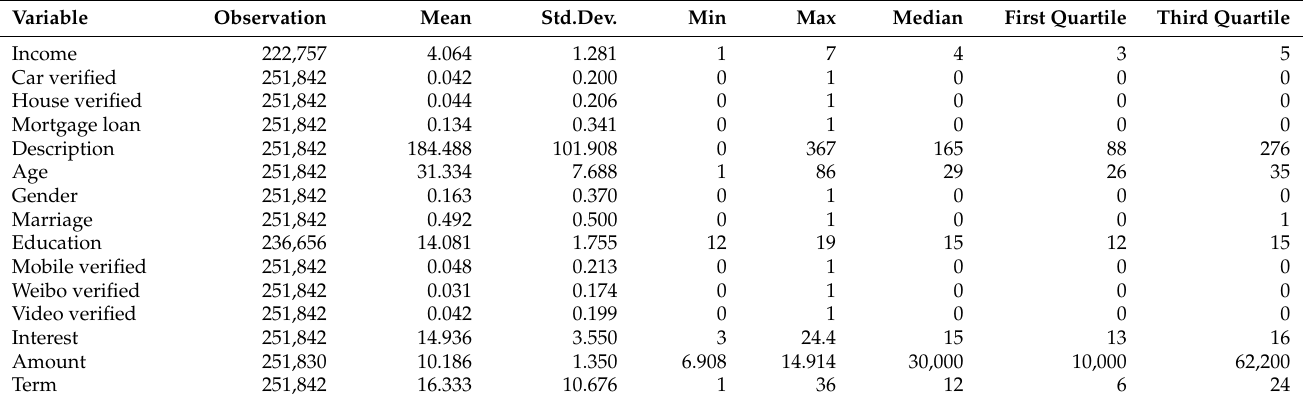
Table 1. Descriptive Summary of Independent